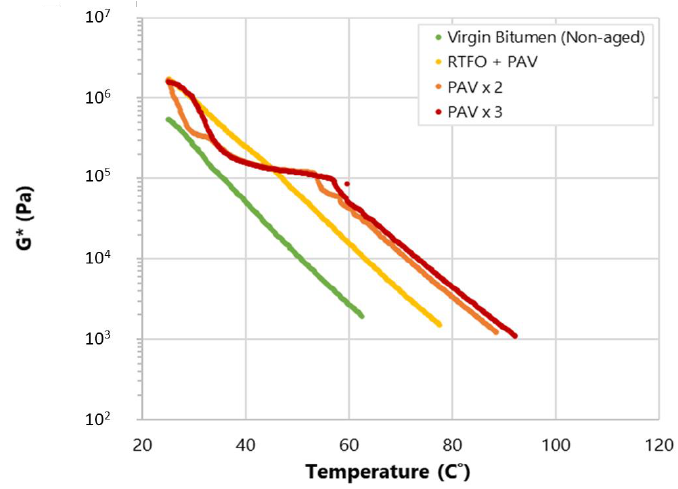
Figure 1. Complex modulus G* vs. temperature of reference samples.